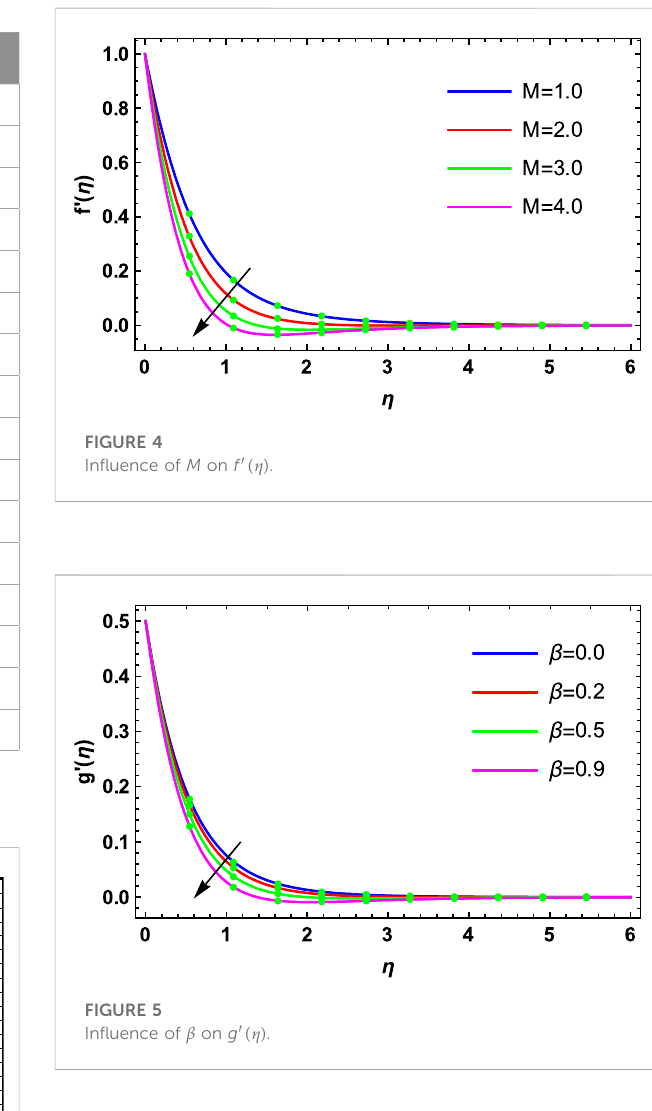
TABLE 3 Impacts of Nb , Nt , Sc , and K on Re − 1 2